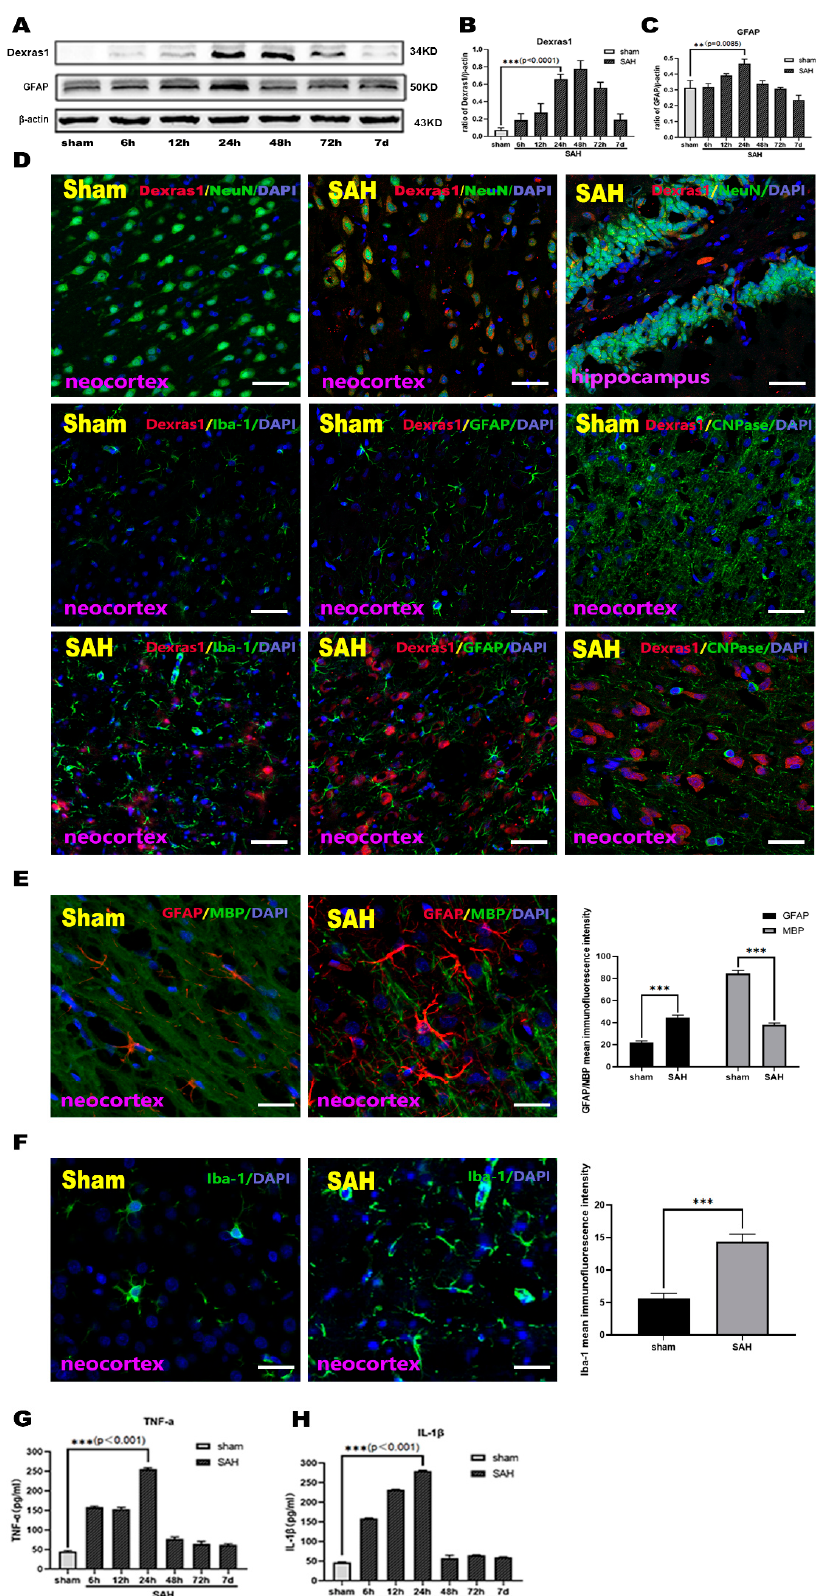
Figure 3. ( A ). Representative Western blots of Dexras1 and GFAP; ( B , C ) protein quantification of Dexras1 and GFAP, analyzed by Fusion (fx 7 Spectra, Vilber, France). Results are presented as percent- ages in relation to β -actin levels. ** p < 0.01, *** p < 0.001 vs. sham.; ( D ) represeantative